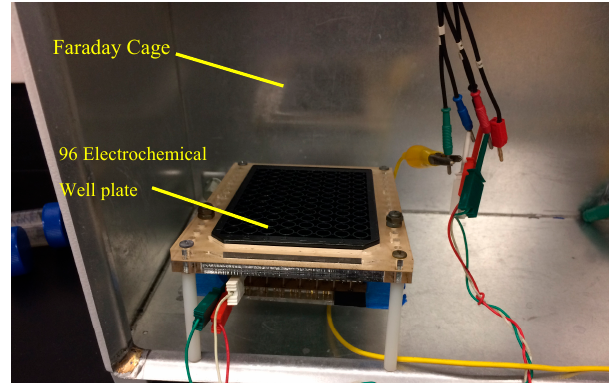
Figure 2. Experimental setup displaying the Faraday cage and custom electrochemical well plate reader.